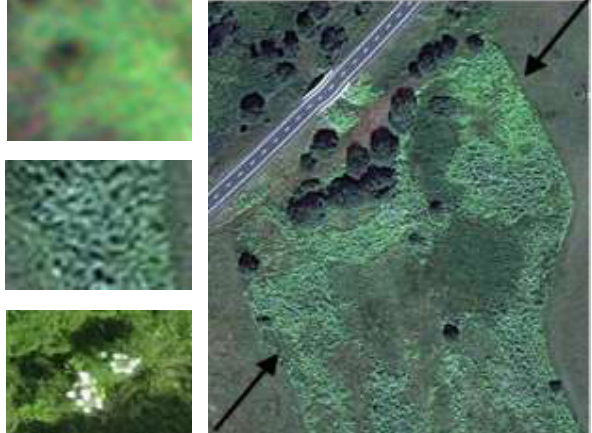
Figure 1. Giant hogweed on Pleiades satellite imagery (right). On the left are details of flowering plants captured by RapidEye, Pleiades and UAV (from up to down, spatial resolution of 6.5 m, 2.8 m and 5